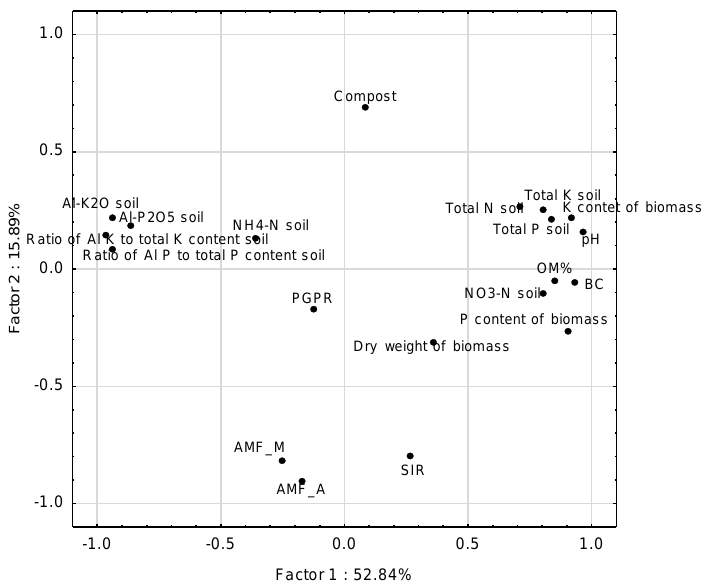
Figure 2. Biplot of the first two principal components of the soil and maize properties and biochar (BC), Compost and plant growth-promoting rhizobacteria (PGPR) treatment.